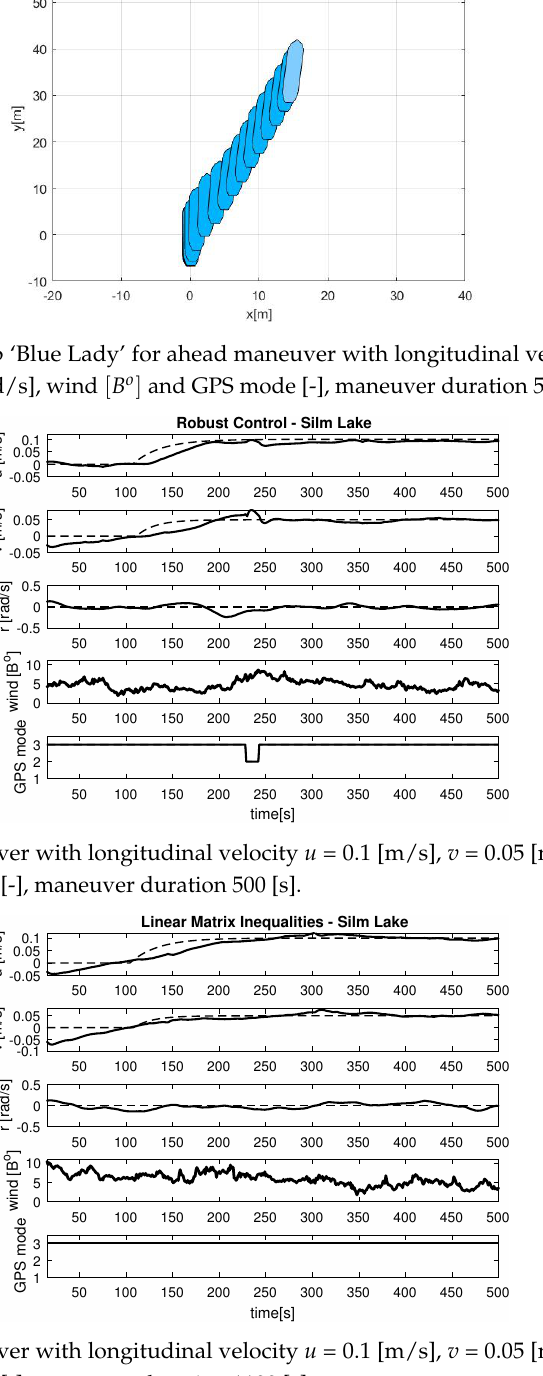
Figure 13. Ahead maneuver with longitudinal velocity u = 0.1 [m/s], v = 0.05 [m/s], r = 0.0 [rad/s], wind [ B o ] and GPS mode [-], maneuver duration 1100